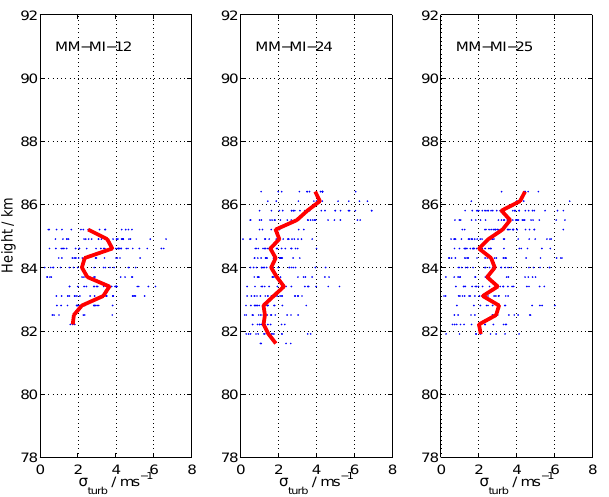
Fig. 10. Variance of turbulent energy dissipation rates for the aver- age time period of 20min around the rocket launches together with the estimated error of the rocket data analysis.